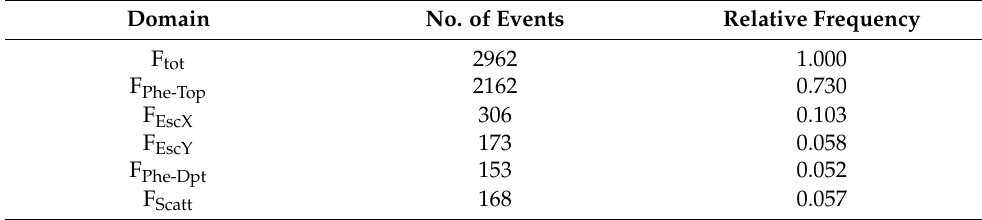
Table 2. Co-57 data-token, pixel 605: experimental events-count and relative frequencies per domain.